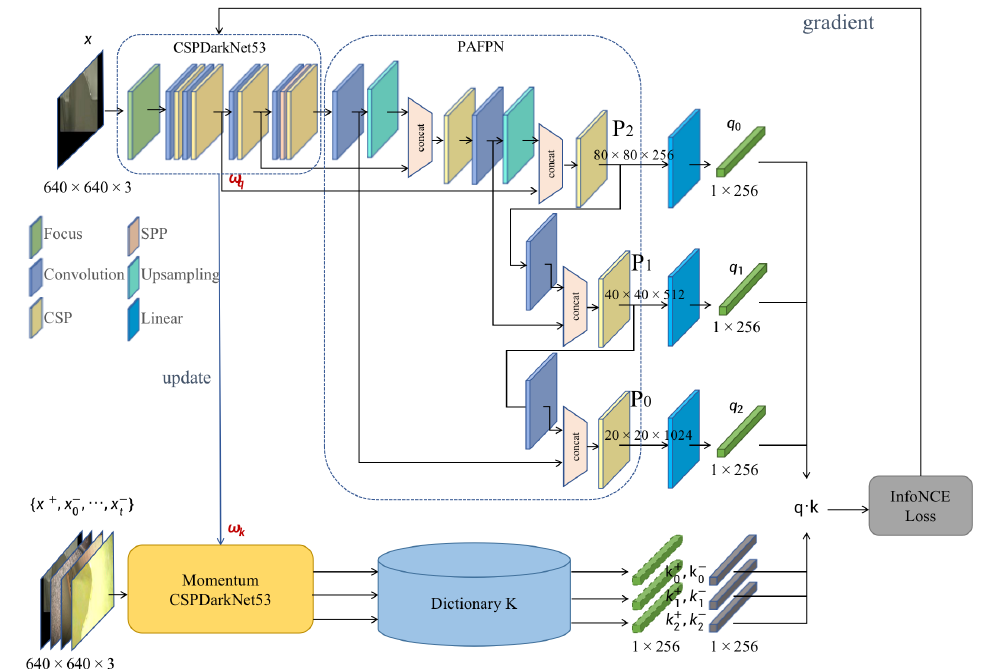
Figure 2. The encoder uses five cascaded CSP modules to downsample the features and then uses an SPP module to increase the receptive field of the network. The feature map is subjected to three maximum pooling of different sizes through this module. The feature pyramid fuses the output features of the backbone network, aggregates the information of different layers, and then outputs the anchor sample (sample image to be trained) features through linear transformation. The anchor sample features are compared with the positive and negative samples found in the dictionary, and the feature extraction network is updated to complete the